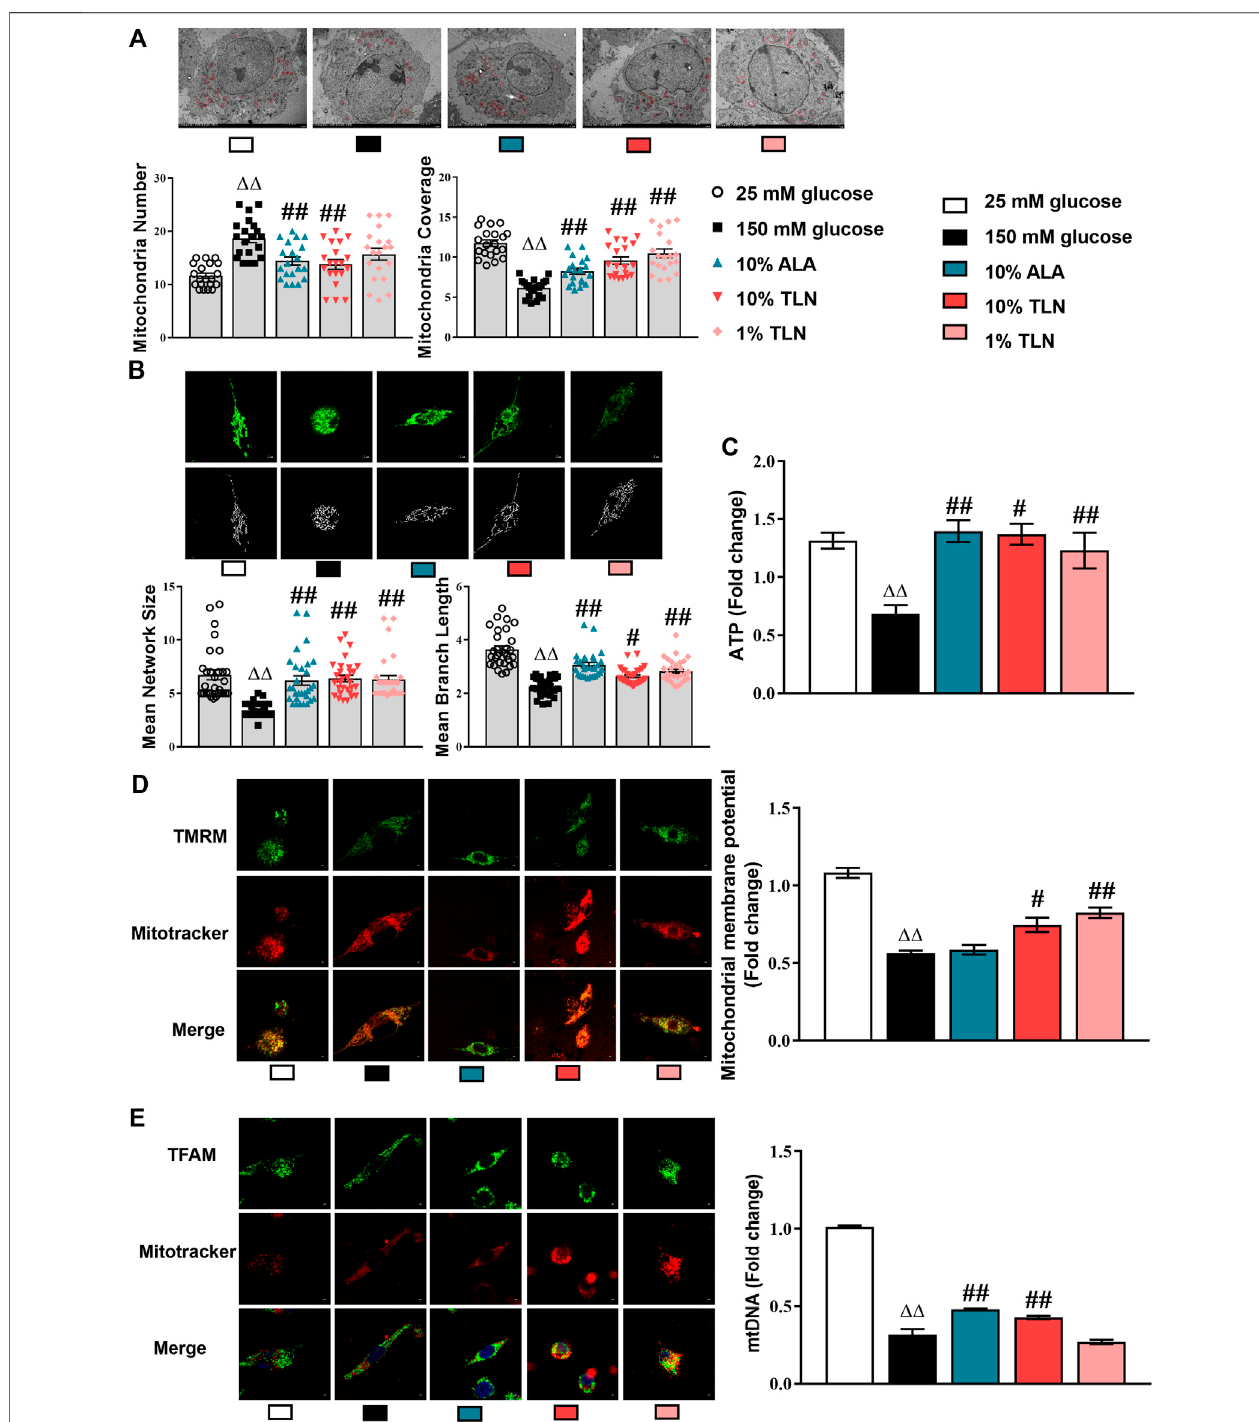
FIGURE 3 | TLN serum treatment improved the mitochondrial structure and function of SCs incubated in a high glucose environment. (A) Representative images and quanti fi cations of themitochondria number and mitochondria coverage of 30 cells. Scale bar, 5 μ m. The results were normalized to the values ofthe 25 mM glucose group. Mitochondria are indicated by red circles. (B) Representative images and quanti fi cations of themean network size and mean branch length of 20 cells. Scale bar, 5 μ m. (C) Quanti fi cation of ATP, n (cid:1) 4 for each group. (D) Representative images of immuno fl uorescence staining on TMRM (green) and mitochondria (red); scale bar, 5 μ m, and quanti fi cation of mitochondrial membrane potential, n (cid:1) 4 for each group. (E) Representative images of immuno fl uorescence staining on TFAM (green) and mitochondria (red);scale bar, 5 μ m, andquanti fi cationofmtDNA,n (cid:1) 4for each group. ΔΔ P < 0.01 vs. 25mM glucosegroup; ## P < 0.01, # P < 0.05 vs. 150 mM glucose